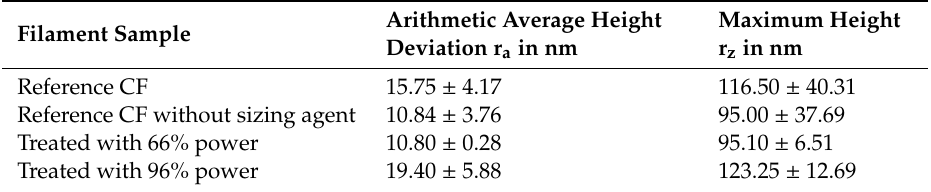
Table 1. Arithmetic average height and maximum height of the atomic force microscopy (AFM) samples.